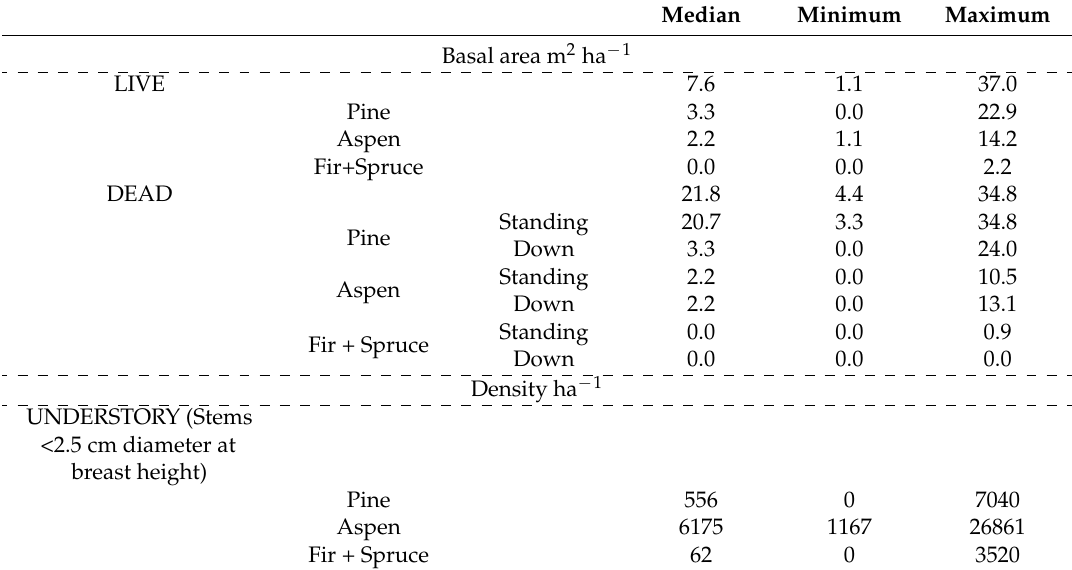
Table 1. Summary of the basal area and the understory tree density in the sampled stands ( n = 33).